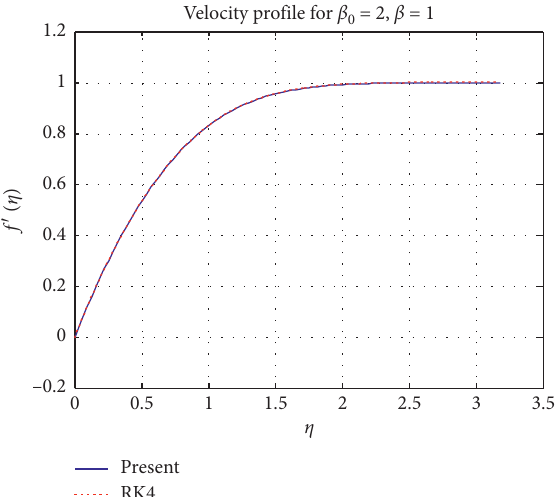
� 0 and β � 1). f ″ ( 0 )� 1.154700538379 for L � 6.98476. 0